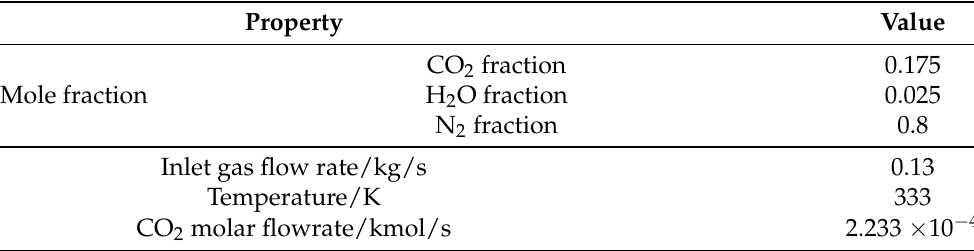
Table 1. Flue gas